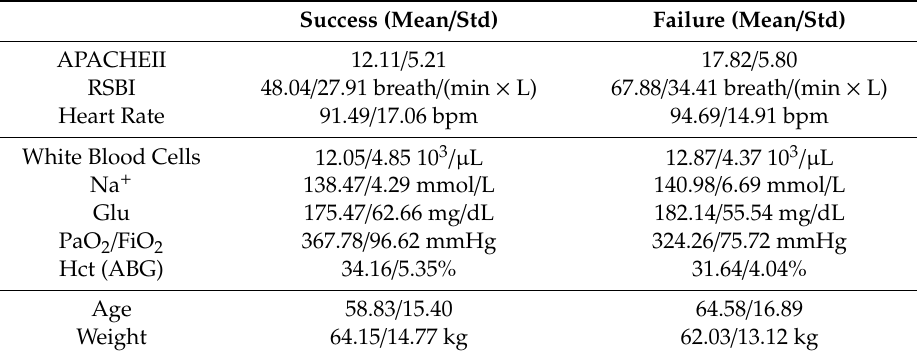
Table 1. Patients’ characteristics with some